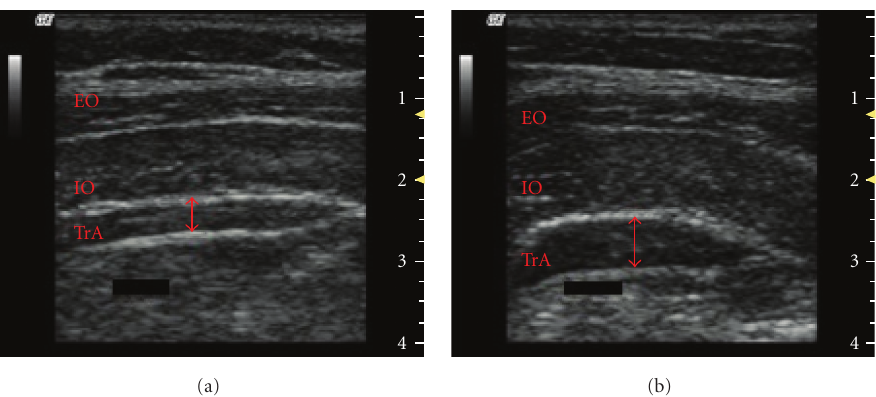
Figure 4: Ultrasound image of the TrA and calculation of TrA activation ratio. Resting image is on (a) and contracted image is on (b) (Activation ratio = TrA contracted (mm)/TrA rest (mm)). EO = external oblique; IO = internal oblique; TrA = transverse abdominis. The red arrow indicates the thickness of the